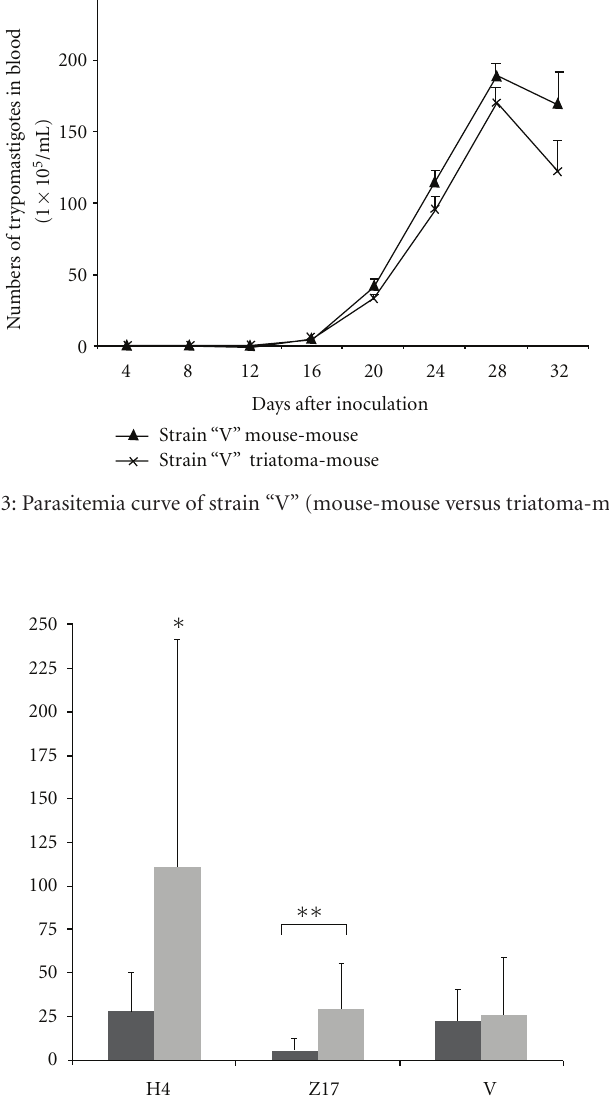
Amastigote nests were only observed on the cardiac tissue. When comparing the three strains (H4, Z17, and V), the H4 strain mouse-mouse produced the greatest number of nests ( < 0.05 in comparison with all evaluated groups). In the groups triatoma-mouse, from strains H4 and V, the number of amastigote nests were 28 and 22, respectively, and for the Z17 strain, were counted only 5 nests. This reduction was statistically di ff erent ( < 0.05) when compared between mouse to mouse group versus triatoma to mouse group (Figure